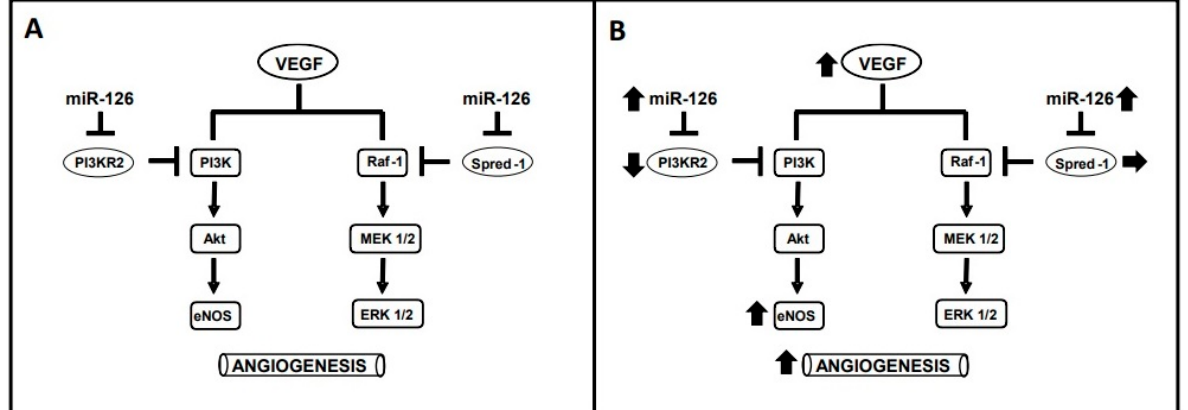
Figure 1. ( A ) Actions of miRNA-126 on the angiogenic pathways of the vascular endothelium growth factor (VEGF). ( B ) Effects of walking training on increasing ( ↑ ), decreasing ( ↓ ) or maintaining ( → ) each component of the angiogenic pathways of VEGF. PI3R2—phosphoinositol-2 kinase regulatory subunit 2; PI3K—Phosphoinoisitede 3-kinase; Akt—Protein kinase B; eNOS—nitric oxide synthase; SPRED-1—sprouty-related protein 1; RAF-1—threonine-protein kinase; MEK ½—mitogen-activated protein kinase kinase; ERK ½—extracellular signal-regulated kinases.